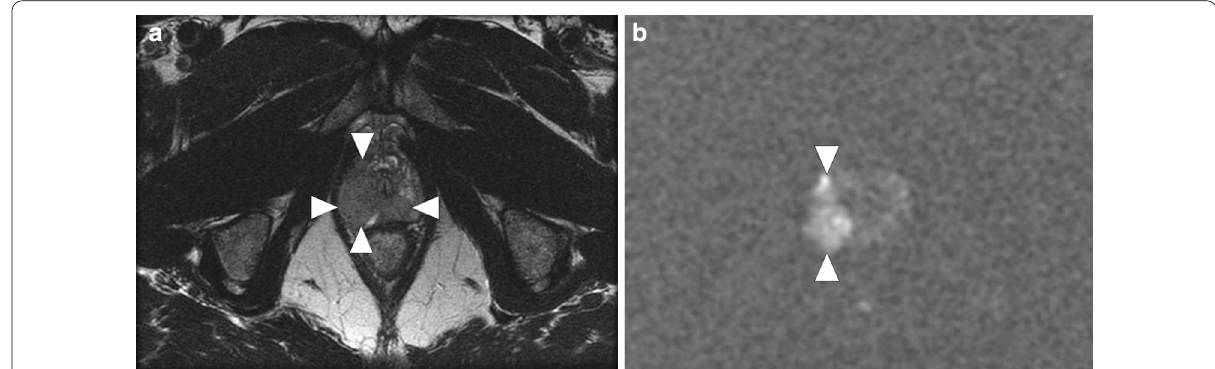
Fig. 1 Granulomatous prostatitis after BCG therapy. A 62-year-old man with a history of bladder cancer treated with cystoscopic surgery and intravesical BCG therapy now presenting with deep pelvic pain and difficulty with urination. Axial T2-weighted image a of the prostate demonstrates a large hypointense lesion (arrowheads) on the right lateral and posterior peripheral zone of the prostatic apex. Axial